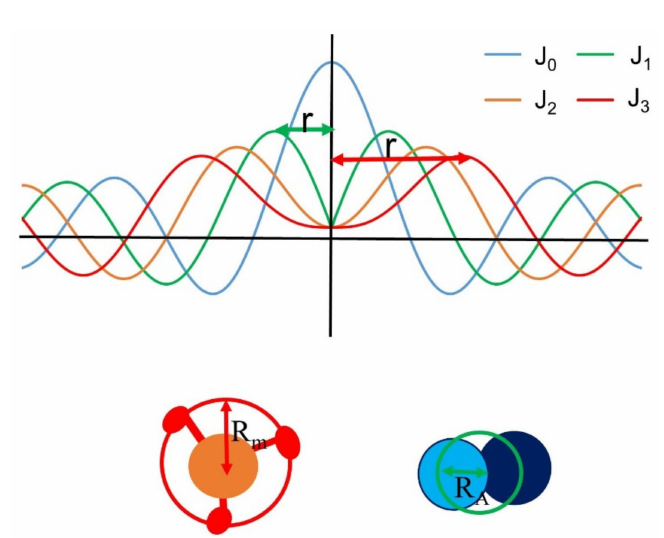
Figure 6. Relationship between the radius of the helical diffracting object and the distribution of intensity on a layer line. R m is the radius to the center of mass of the quasi-helically arranged myosin heads and R A is the radius to the center of mass of an actin subunit. J 0 –J 3 (generally J n where n is an integer) are Bessel functions of the first kind. The order of the Bessel function ( n ) can be determined from Equation (1) or Equation